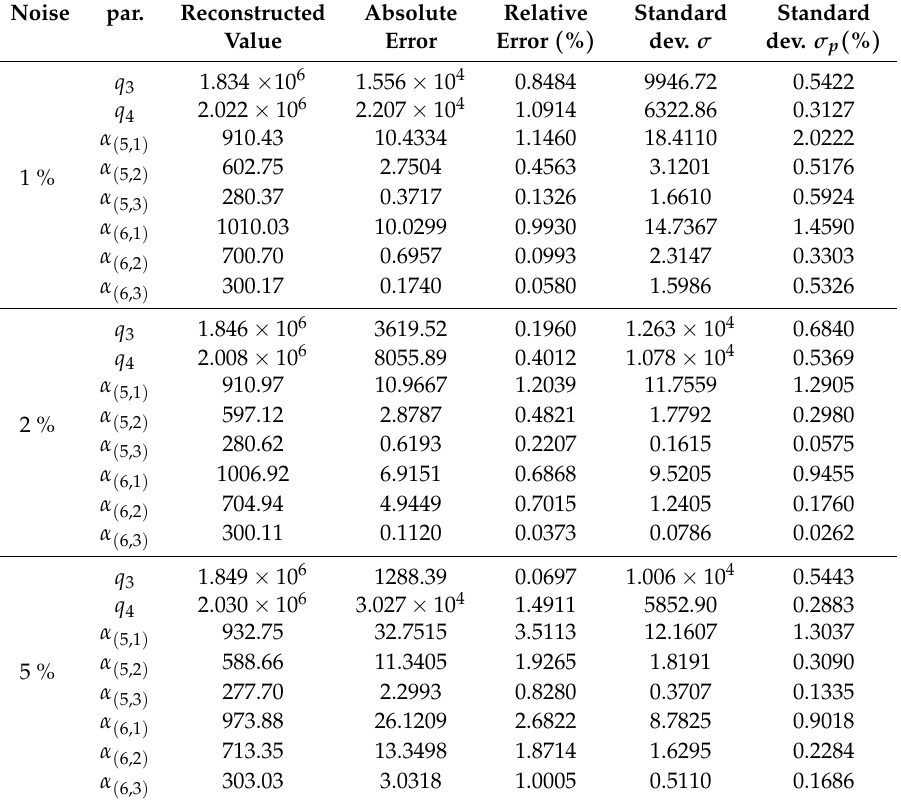
Table 1. Reconstructed values of the unknown coefficients together with the absolute and relative errors of these reconstructions, the standard deviation σ and the standard deviation σ p taken as the percentage of the best reconstructed value, obtained for the measurements read at every 0.01m (one step optimization).